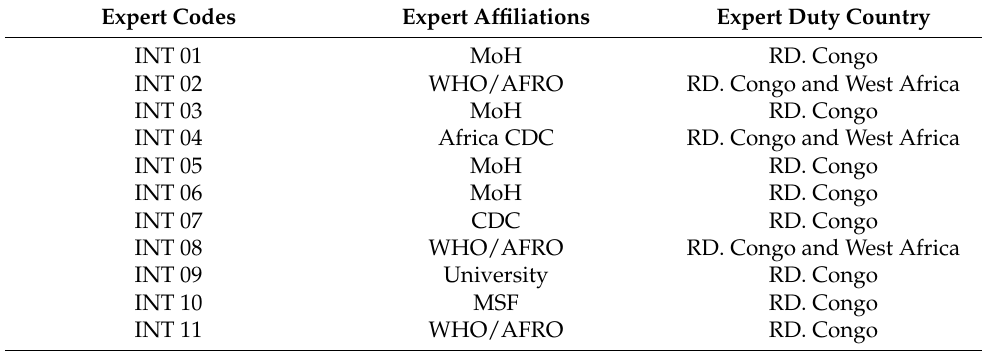
Table 1. Details on the experts interviewed.